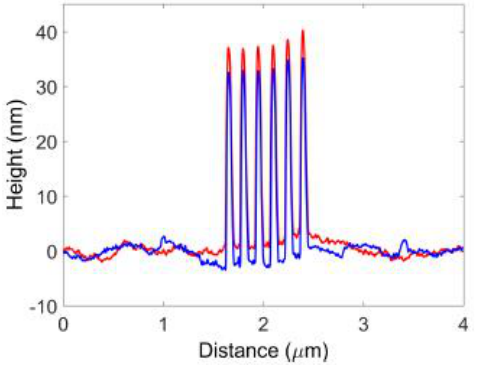
Figure 4. Integrated atomic force microscopy (AFM) height profile taken across the lines shown in Figure 3, which on comparison (Red: as deposited, Blue: after FEBIE) confirm the presence of well separated lines with little or no interconnecting material.